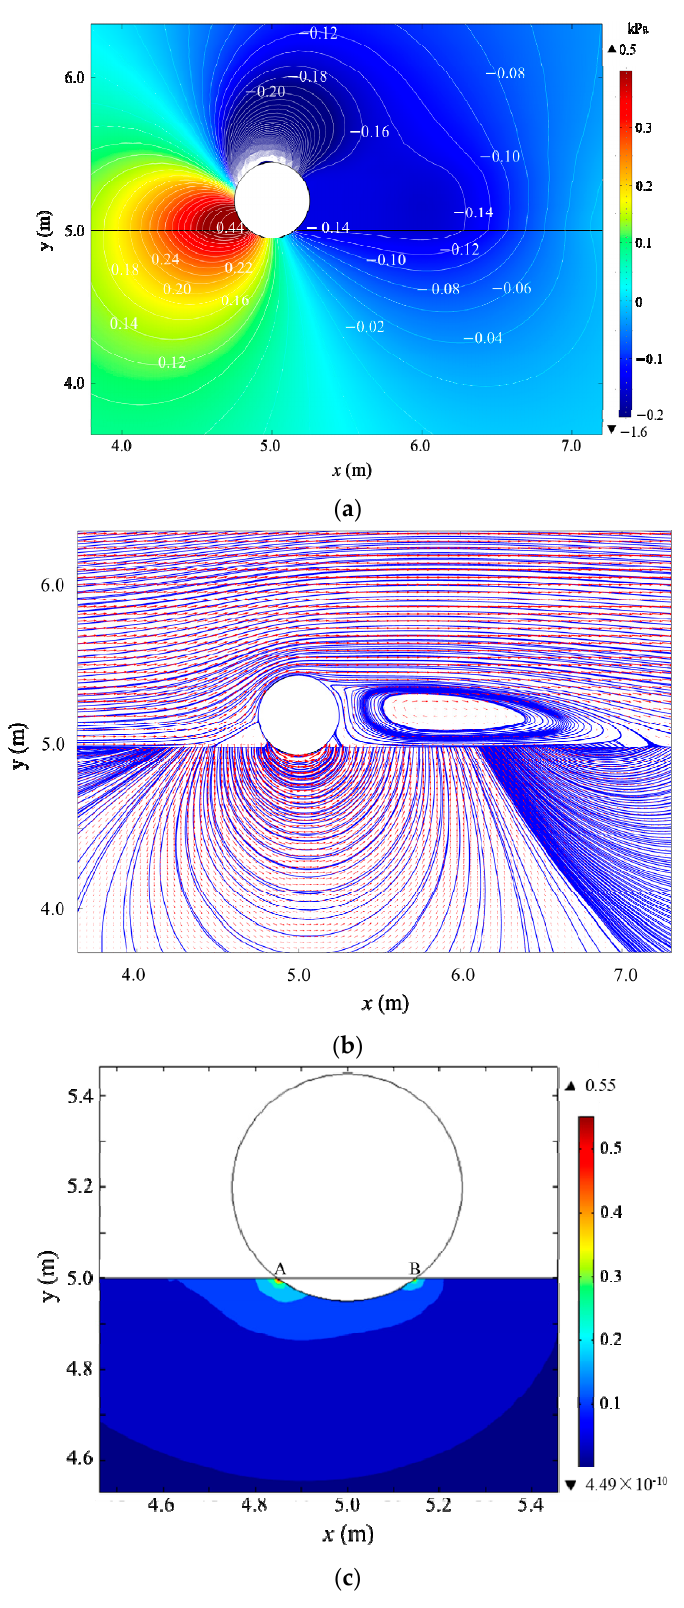
Figure 6. Flow and seepage flow around the pipe in steady currents ( U = 1.0 m/s): ( a ) cloud diagram and contour of flow pressure and seepage pressure; ( b ) streamline; ( c ) contour of hydraulic gradient.